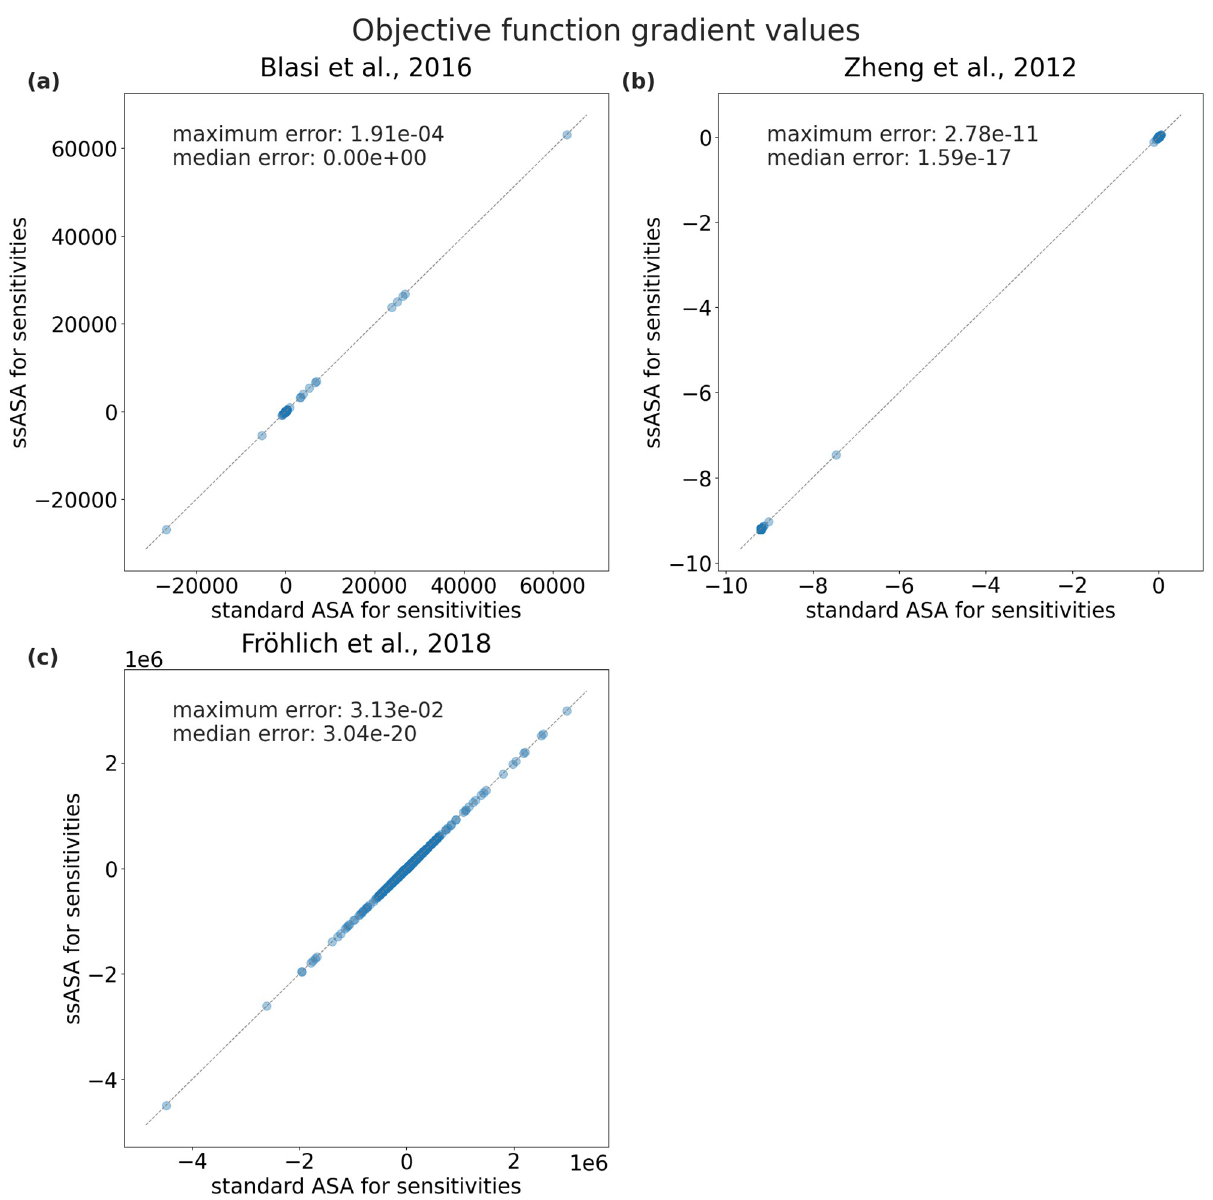
Fig 3. Accuracy of objective function gradients of the proposed method. In each of the three subplots one point corresponds to an objective function gradient value computed during one simulation using either standard ASA (x-axis) or ssASA (y-axis) for sensitivities computation. The number of points in each subplot is equal to the number of optimized parameters multiplied by the number of simulations. Points close to the diagonal indicate a good